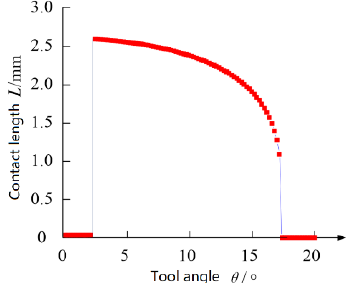
Figure 16. Cutting edge contact length in different tools angles.